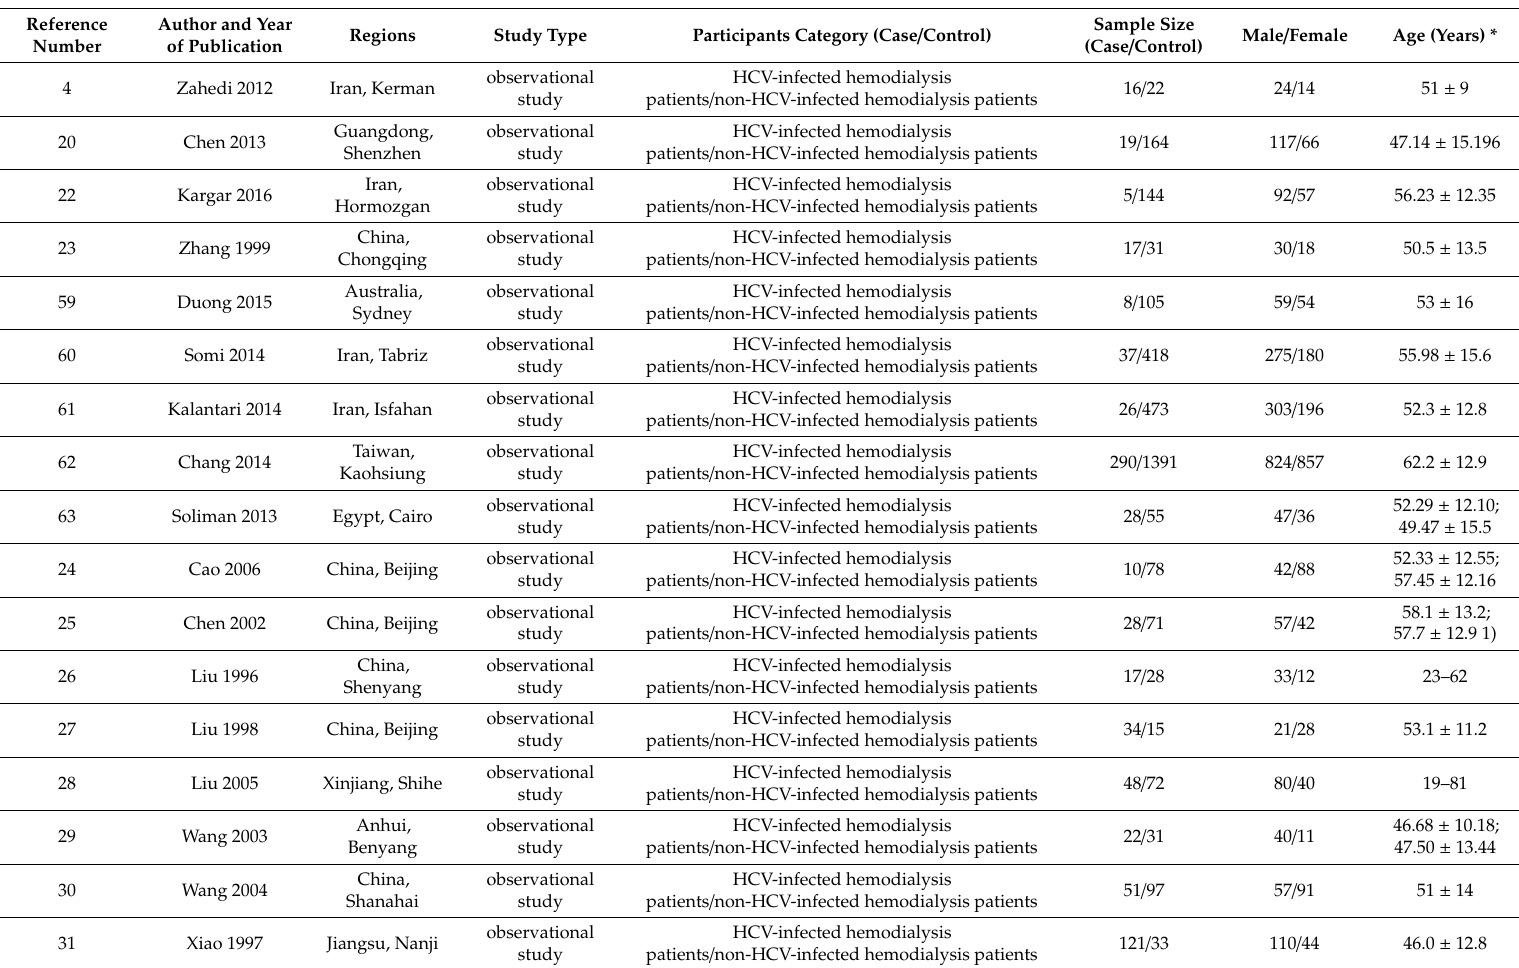
Table 1. Characteristics of the